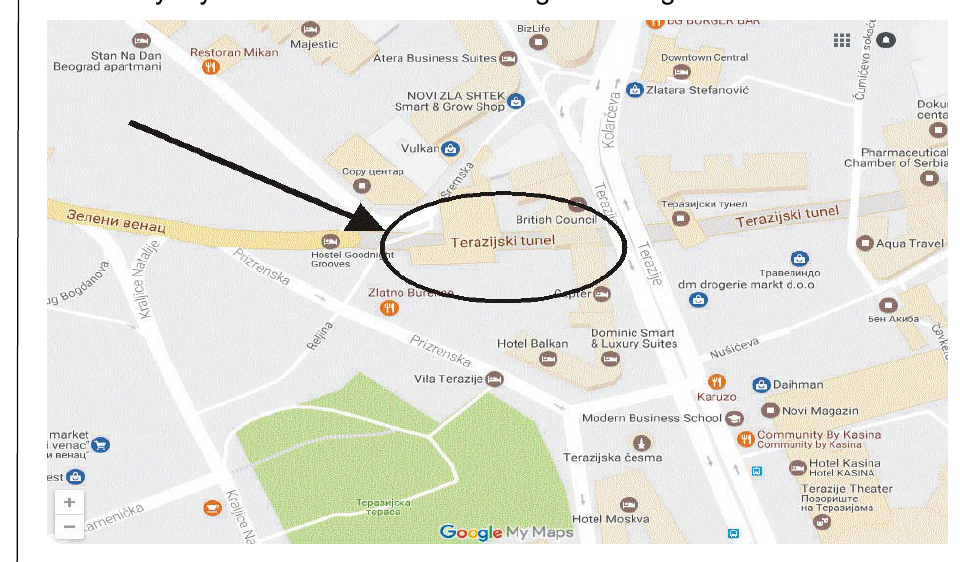
Figure 2 – Tunnel at Terazije, marked on the map of Belgrade Рис . 2 – Тоннель „ Теразие “, обозначен на карте Белграда Слика 2 – Теразијски тунел означен на карти Београда